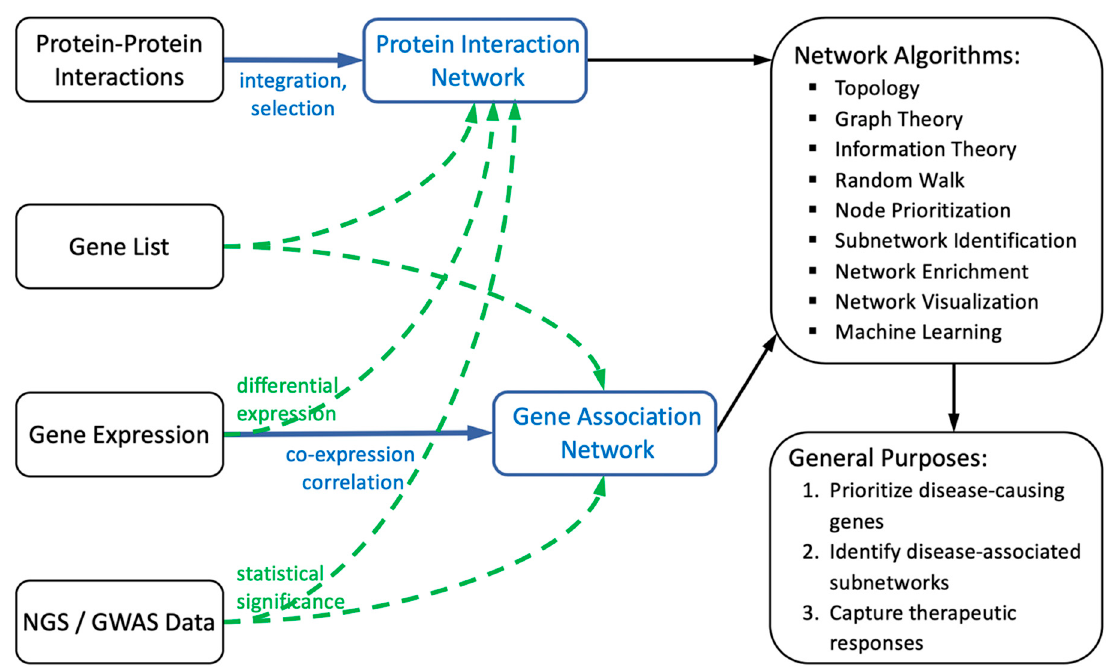
Figure 1. A flowchart illustrating the general framework of biological network studies. The blue arrows and text correspond to the construction of biological networks, whereas the green arrows and text correspond to the mapping of biological data onto the network.